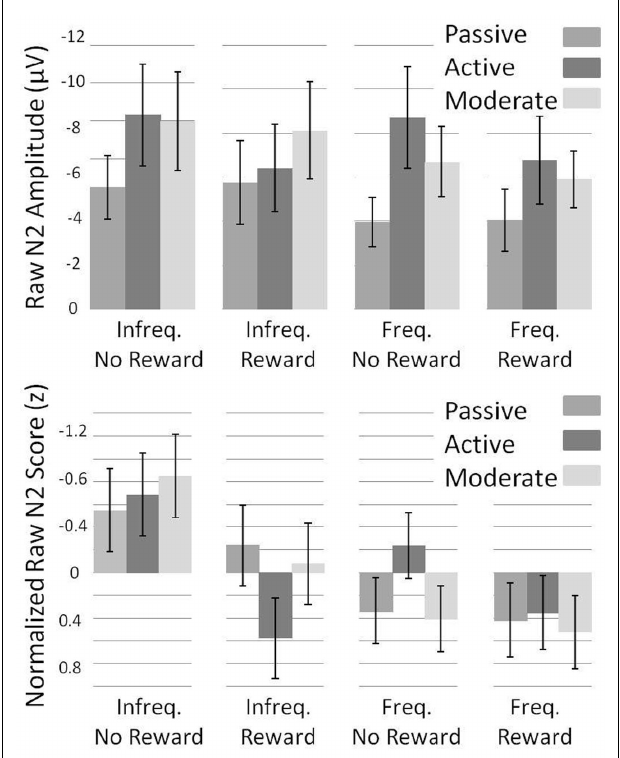
FIGURE 7 | Normalized (bottom) and un-normalized (top) raw-N2 z -scores and amplitudes across experiments for each of the frequency by reward conditions. Note that negative is plotted up. Error bars represent 95% confidence intervals for the mean of each condition by